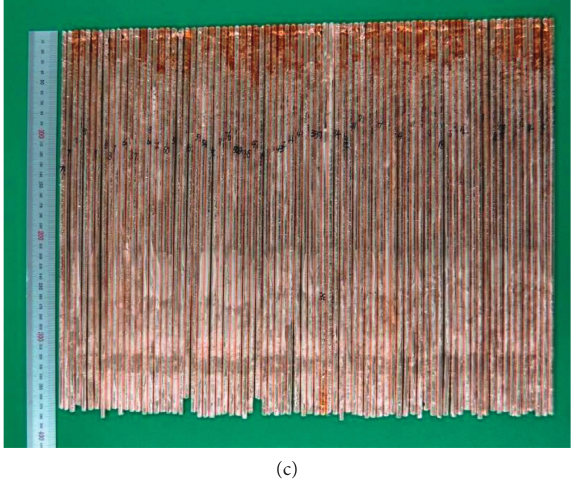
Figure 12: Copper metallic fuel slugs obtained through remote fabrication in RFFM. (a) Mold assembly holding 78 quartz molds filled with cast slugs. (b) 78 cast slug-filled quartz molds separated from mold assembly. (c) 78 cast slugs obtained by breaking quartz